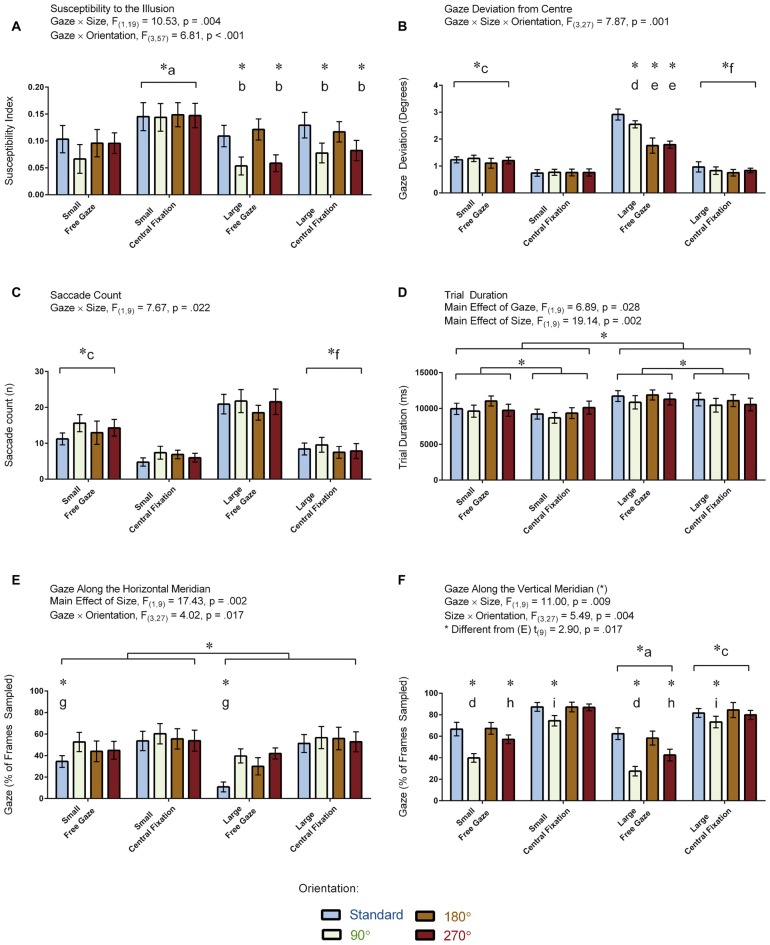
Results for the vertical-horizontal illusion experiment. The figure depicts the means and standard errors (SEM) for each condition for each of the following dependent variables: (A) illusion susceptibility index; (B) gaze deviation from center (degrees of visual angle); (C) saccade count (n); (D) trial duration (ms); (E) gaze along the horizontal meridian (% of frames sampled); and, (F) gaze along the vertical meridian (% of frames sampled). All asterisks (*) denote significant differences after corrections were applied for multiple comparisons (pcorr < 0.05). Labeled asterisks (*) denote differences from: (a) the small free gaze and large central fixation conditions; (b) the standard and 180° orientations for that size × gaze condition; (c) the small central fixation and large free gaze conditions; (d) the standard, 180° and 270° orientations for that size × gaze condition; (e) the standard and 90° orientations for that size × gaze condition; (f) the large free gaze conditions; (g) the 90°, 180° and 270° orientations for that size × gaze condition; (h) the standard, 90° and 180° orientations for that size × gaze condition; and, (i) the 180° orientation for that size × gaze condition.